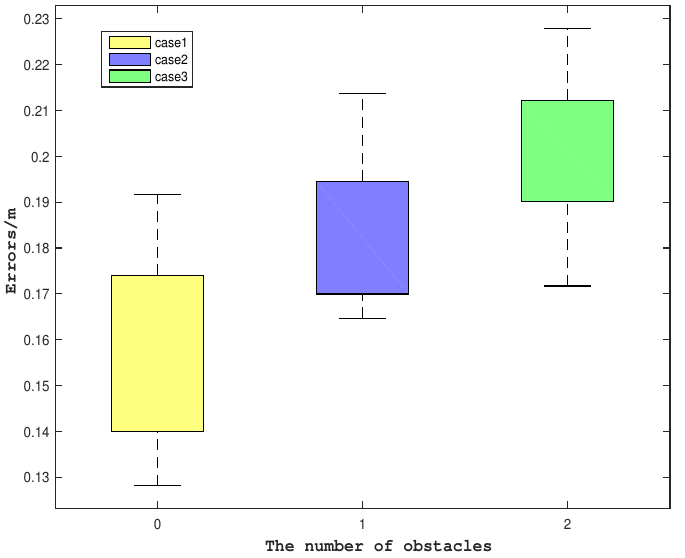
Figure 9. The robot movement trajectory in the real environment with 3 signal sources and 2 obstacles.